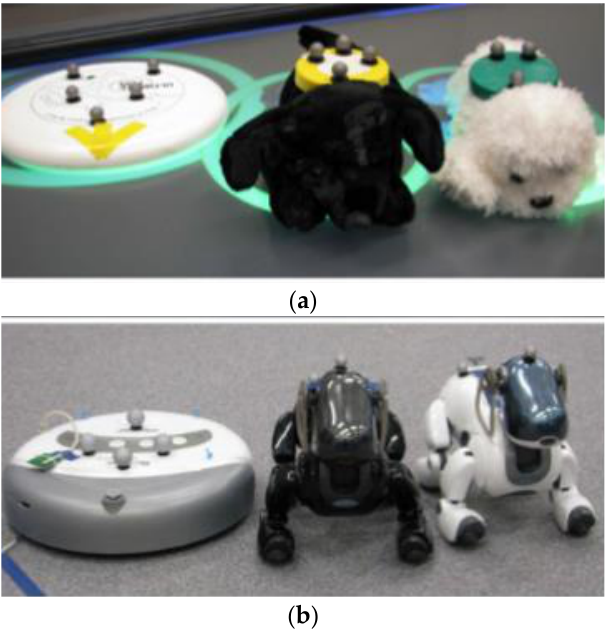
Figure 27. Tangible user interface ( a ), their corresponding robots ( b ) [47].